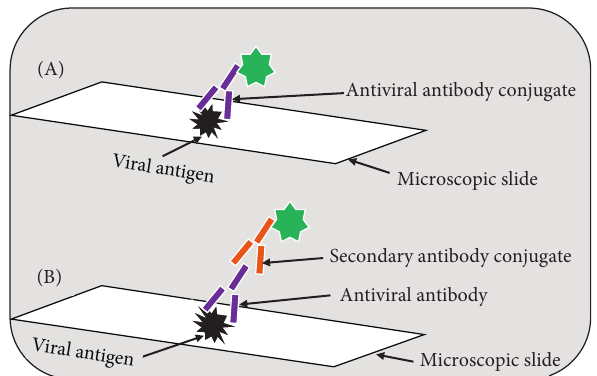
Figure 6: Schematic of the principles of immunofluorescence assays: (A) direct immunofluorescence assay; (B) indirect immunofluo- rescence assay.